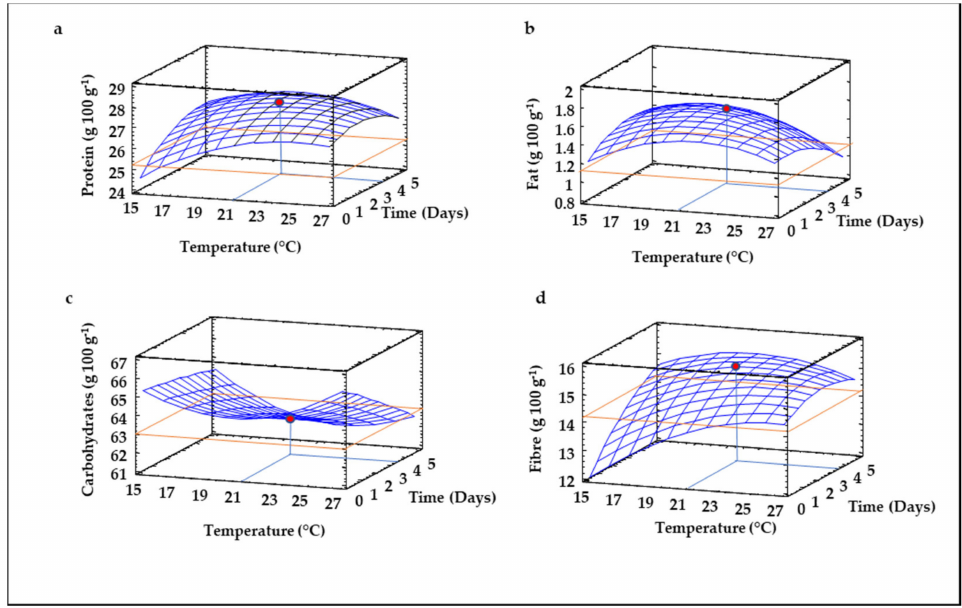
Figure 1. Three-dimensional Response Surface Plots for the content of total protein ( a ), fat ( b ) carbo- hydrates ( c ), and fiber ( d ) as a function of the interaction between germination temperature and time. The red line corresponds with the control (ungerminated seed) and the red point with the value for optimum conditions (21 ◦ C and 3.5